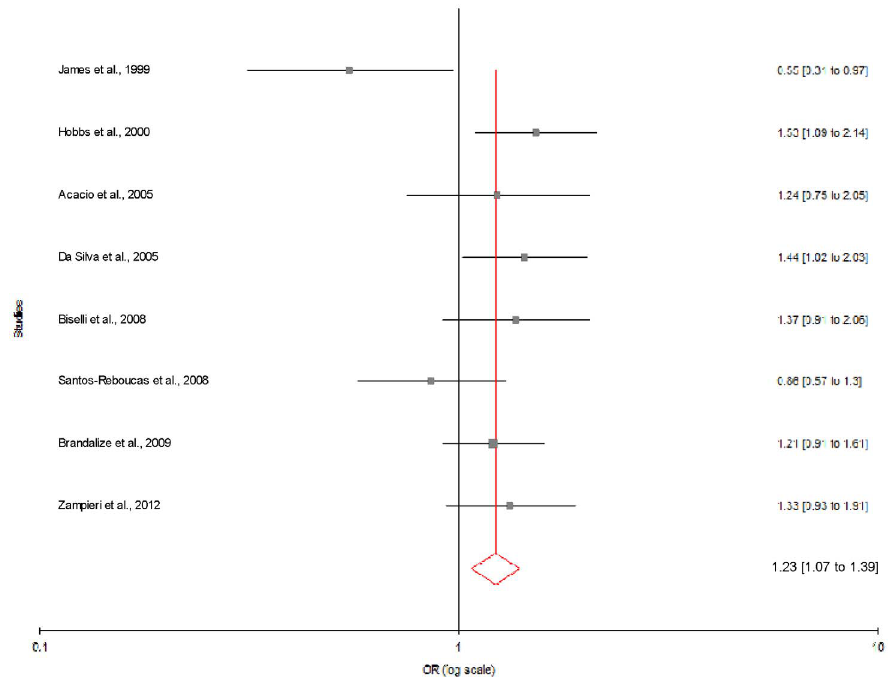
Figure 6. Forest plots (Random effect) showed no association between MTHFR C677T polymorphism and risk of Down syndrome in American studies using allele contrast model (T versus C). Results of individual and summary OR estimates and 95% CI of each study were shown.